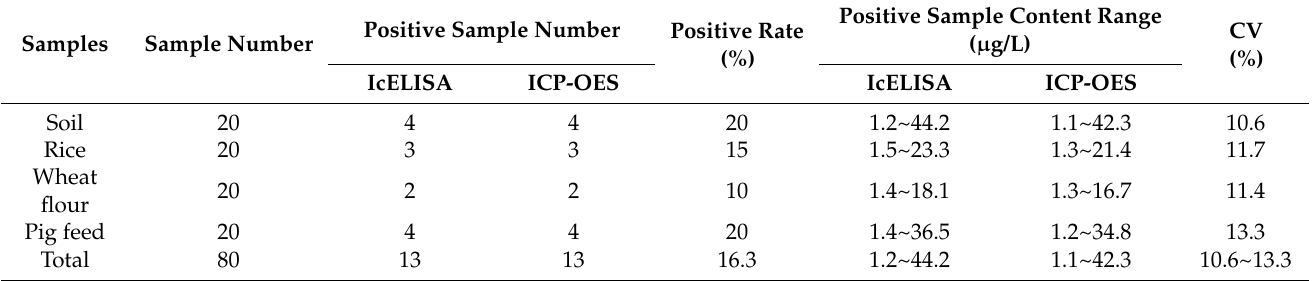
Table 5. Comparison of icELISA with ICP-OES for the determination of Cr(III) in actual